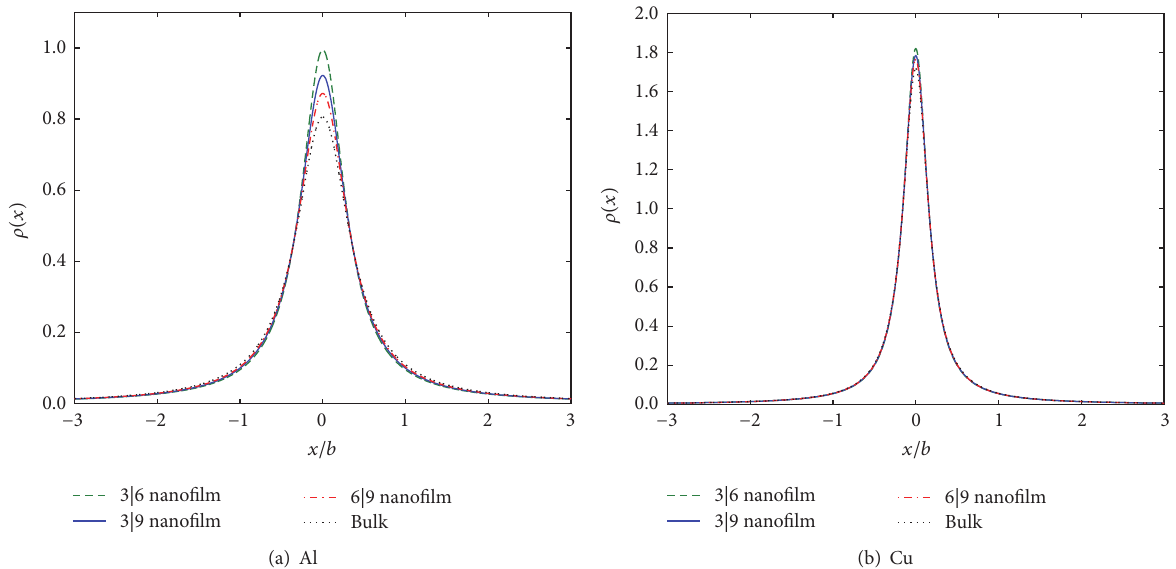
Figure 6: Stress fields of the (1/2)⟨110⟩{111} screw dislocations in Al and Cu nanofilms for different ℎ | (𝐻 − ℎ) .